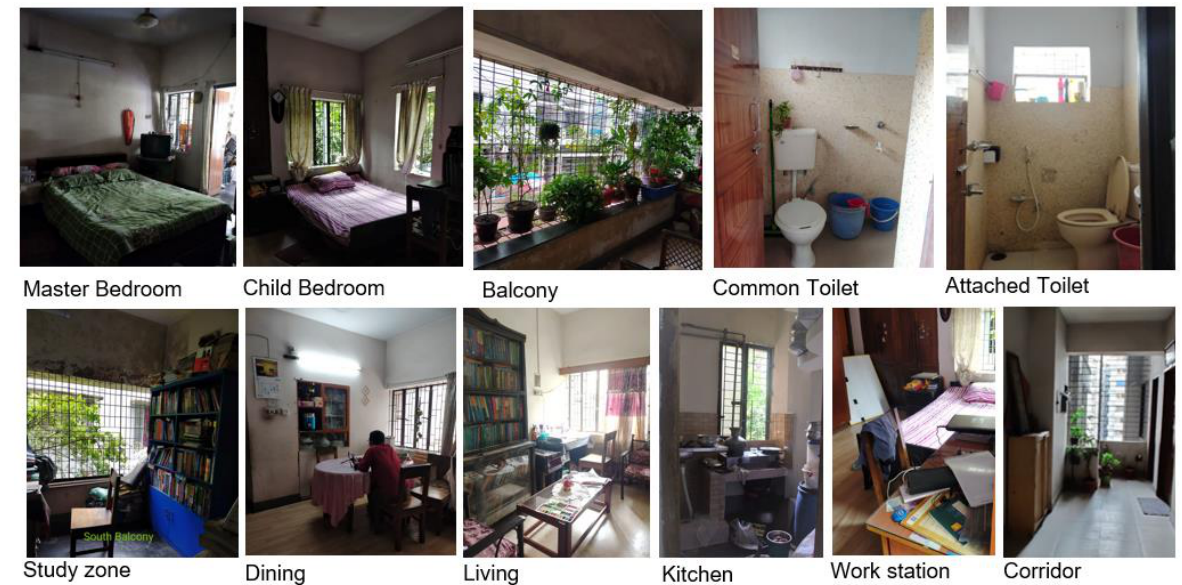
Figure 3. Occupants’ liv ing scenario of high-density urban housing in Dhaka, Bangladesh. (Source: author). Table 2. Identification of different factors from field